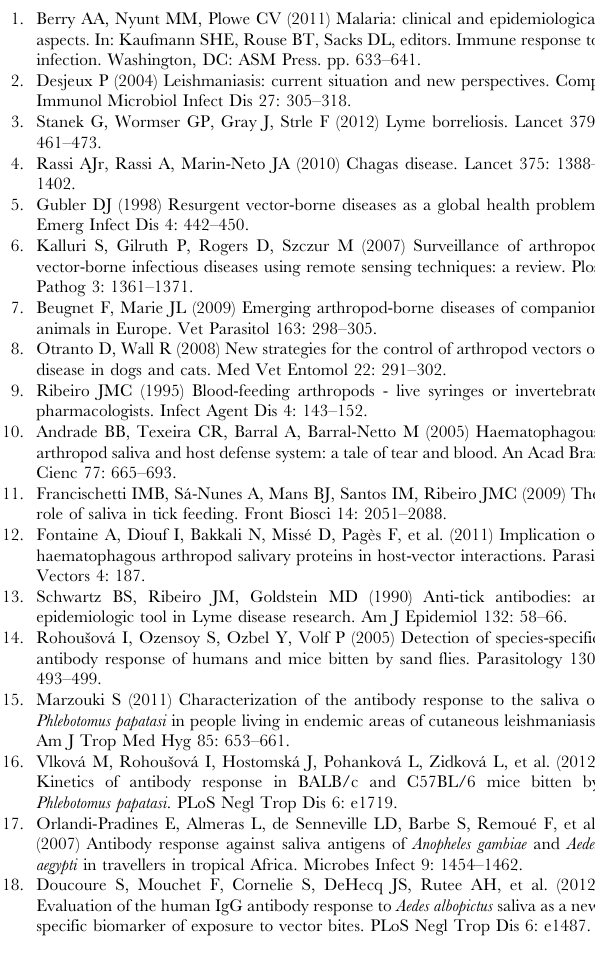
from the 5 th week of exposure to the Peruvian T. infestans strain. This protein is marked with a red circle in the different panels. Table S1 Origin of different Triatoma infestans strains. Table S2 Immunogenic salivary antigens of four differ- ent T. infestans strains. Table S3 Correlation between sum of feeding T. infestans and IgG antibody response of guinea